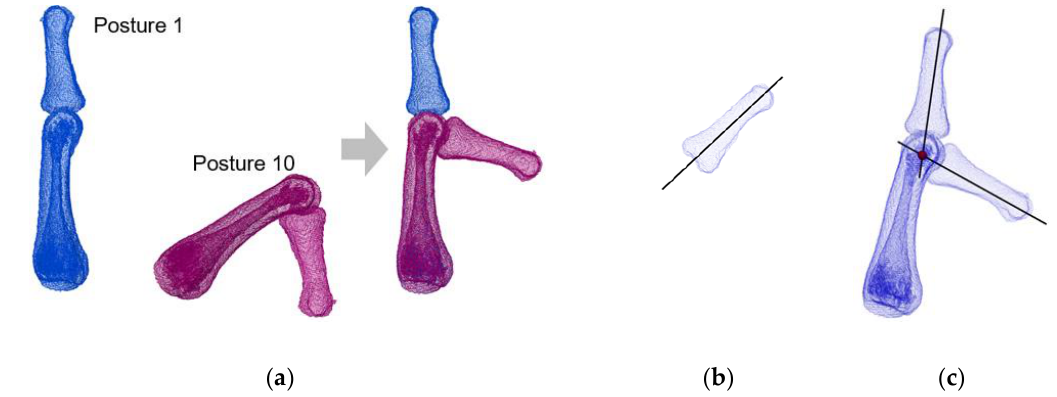
Figure 2. Estimation of a finite center of rotation of a joint between two different postures: ( a ) alignment of proximal bone segments of the joint at different postures; ( b ) identification of the centerline of the distal bone segment of the joint; ( c ) determination of a finite joint center ( red ) as the intersection point of the identified centerlines at different postures.